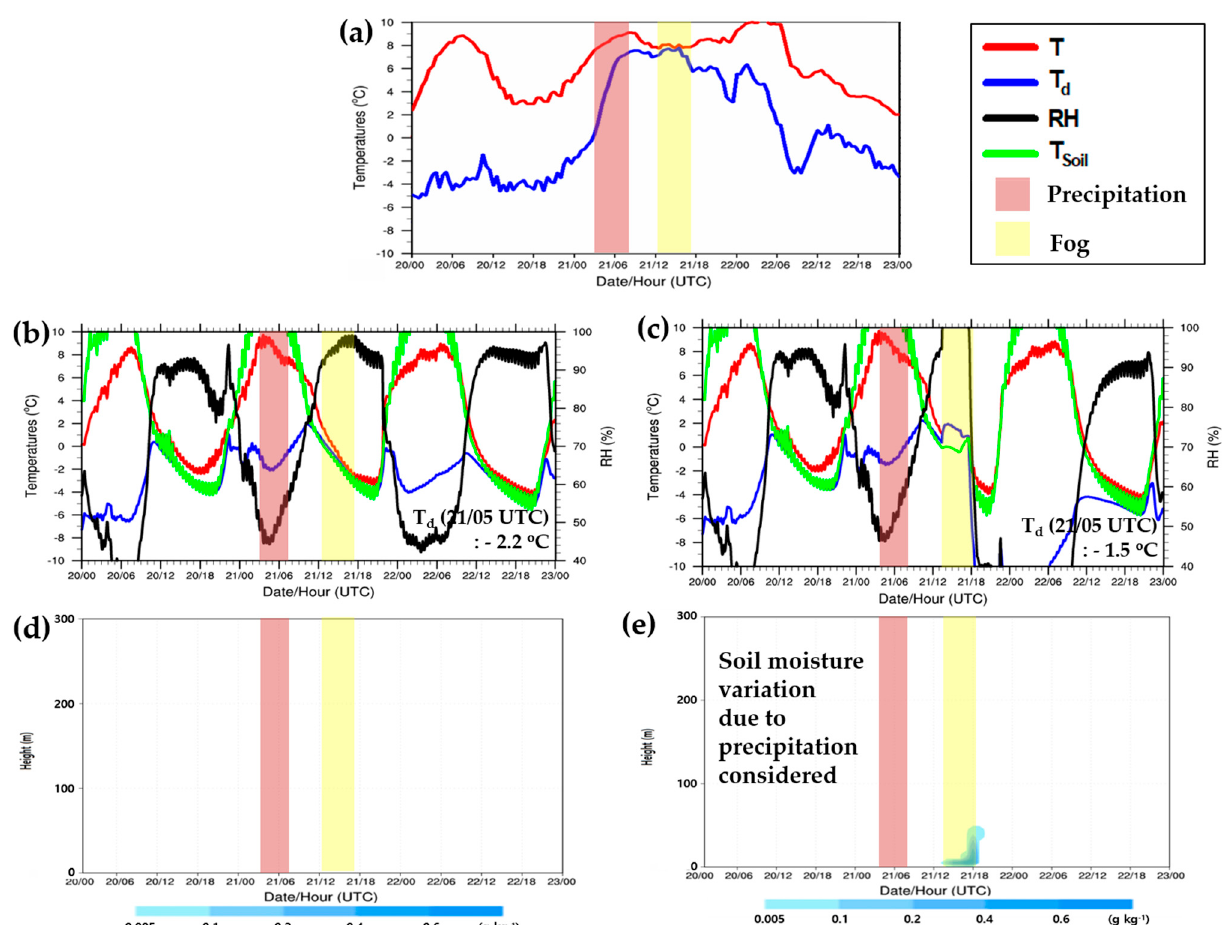
Figure 4. ( a ) Time variation of T and T d measured at BSWO for the highlighted fog case (January 21, 2015; Case 11 in Table 1); ( b ) time variations of T, T d , RH and T s , and ( d ) liquid water mixing ratio from the coupled model simulation with no consideration of the precipitation effect on soil moisture; and ( c ), ( e ) with such consideration. The observed fog (21/14 UTC–21/18 UTC) and precipitation (21/04 UTC–21/08 UTC) times are shaded yellow and brown, respectively. The simulation started at 00 UTC January 20 and lasted 72 h.